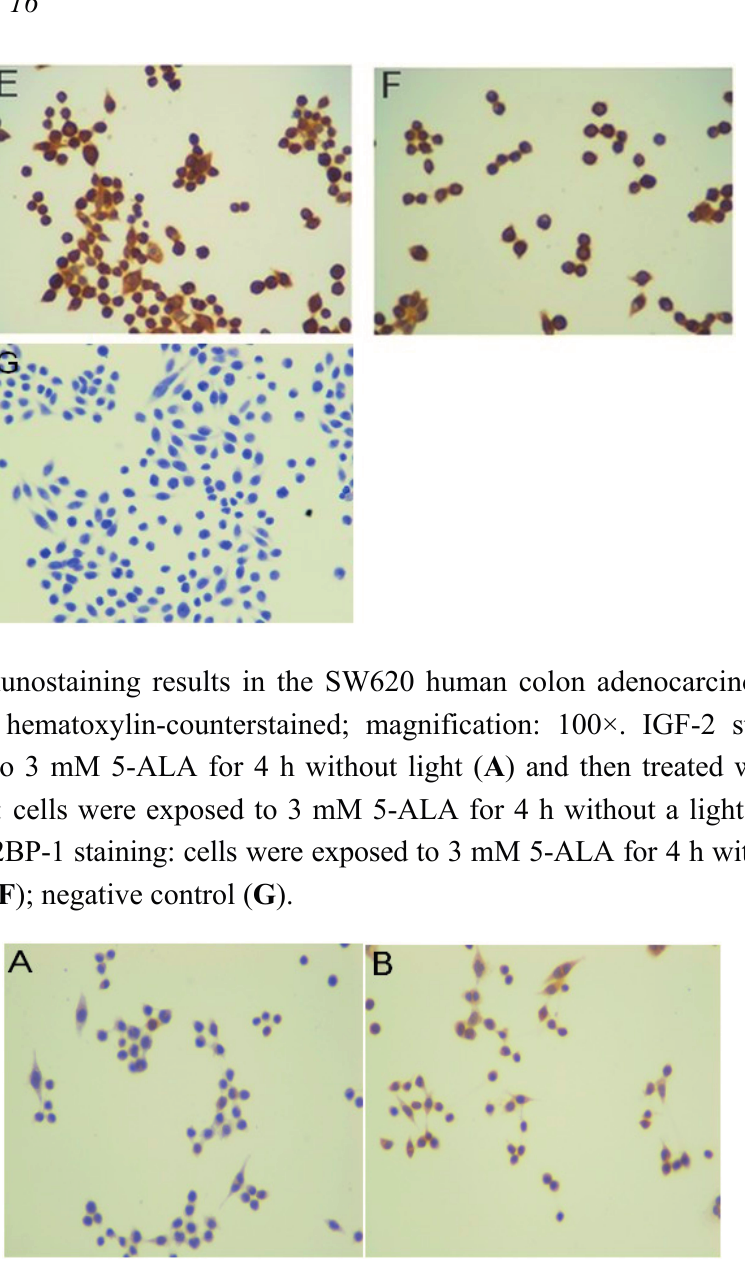
Figure 3. Immunostaining results in the SW620 human colon adenocarcinoma cell line for BAX protein. DAB method, hematoxylin-counterstained; magnification 100×. ( A ) Cells were exposed to 3 mM 5-ALA for 4 h without light and stained with antibody to BAX. No staining was observed in this case (immunoreactivity score (IRS) = 0); ( B )